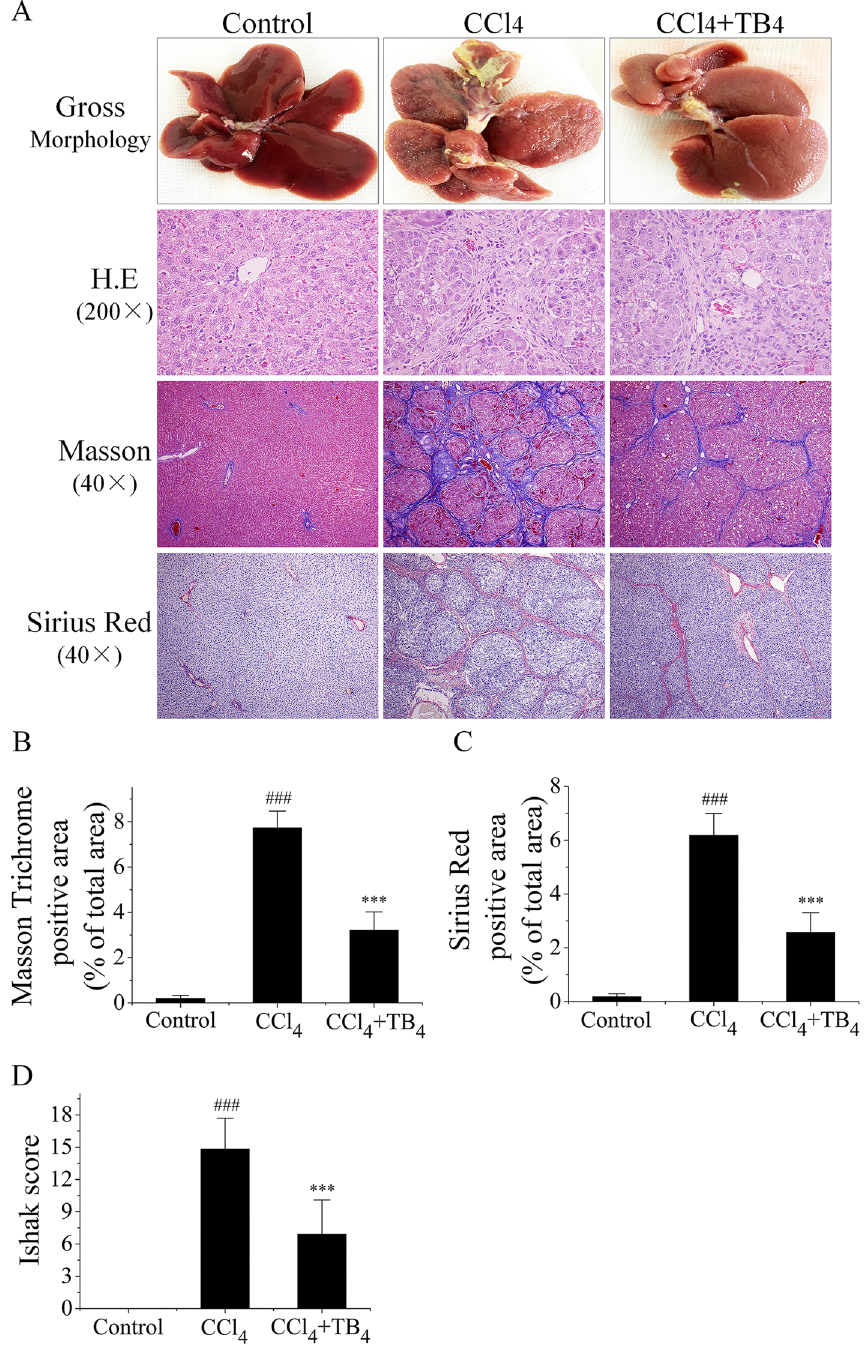
Figure 7. Effects of TB4 on liver fibrosis in rats. ( A ) Representative results of macroscopic appearance and liver histology staining of hematoxylin-eosin (H.E), Masson and Sirius Red were shown. Original magnification was indicated on the figure. ( B ) Semi-quantitative analysis of Masson trichrome staining results. ( C ) Semi- quantitative analysis of Sirius Red staining results. ( D ) Semi-quantitative analysis of liver fibrosis and inflammation using Ishak scoring system. n = 6, control group; n = 10, CCl 4 group; n = 10, CCl 4 + TB4 group. Two liver sections were analyzed for each animals. ### P < 0.05 vs. control group; *** P < 0.05 vs. CCl 4